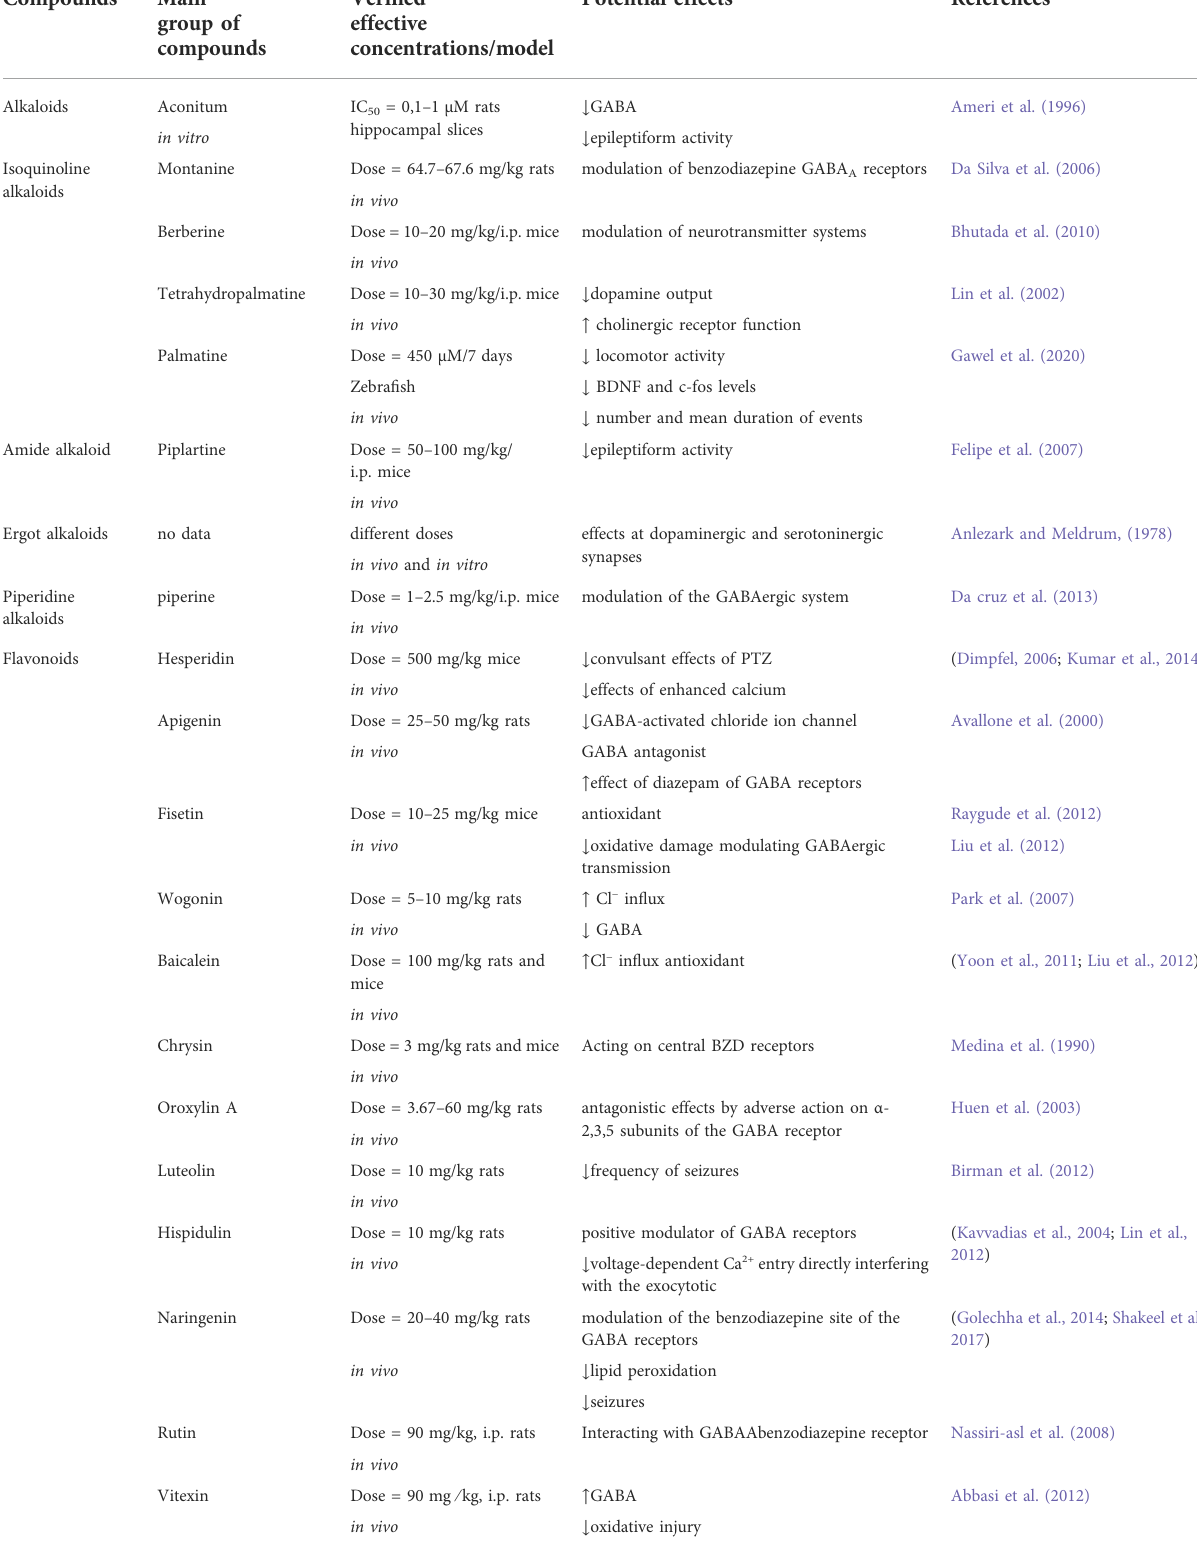
TABLE 7 Phytochemicals and their potential effects in treatment and prevention of neuropsychiatric disorders in